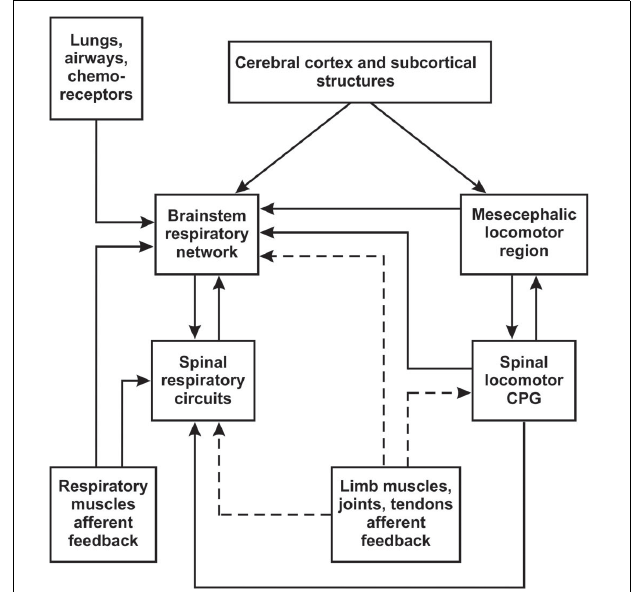
FIGURE 1 | Schematic diagram of possible interactions between locomotor and respiratory systems. Brainstem respiratory network includes medulla and pons (see Section “Overview of Respiratory and Locomotor Networks”). Afferent inputs from limb muscles, joints and tendons are outlined by dashed